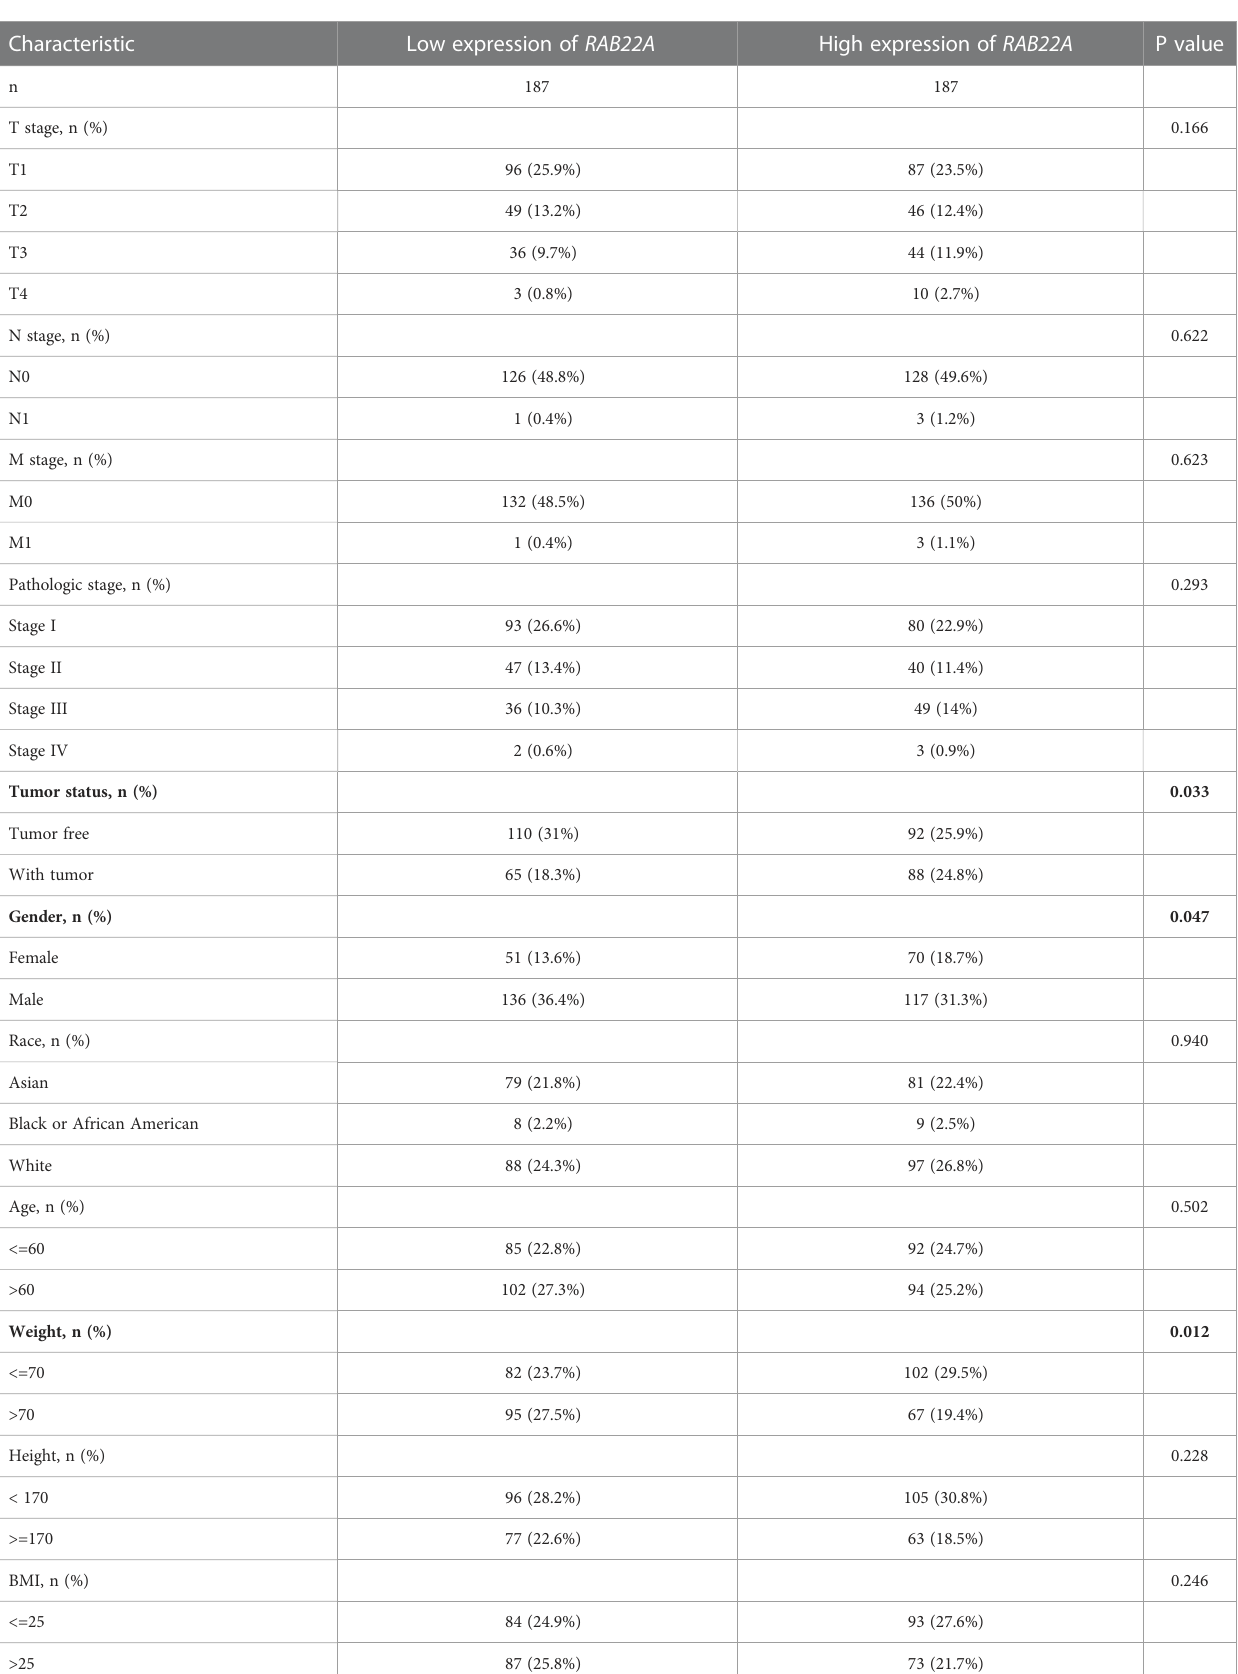
TABLE 2 Correlation between clinicopathological variables and RAB22A